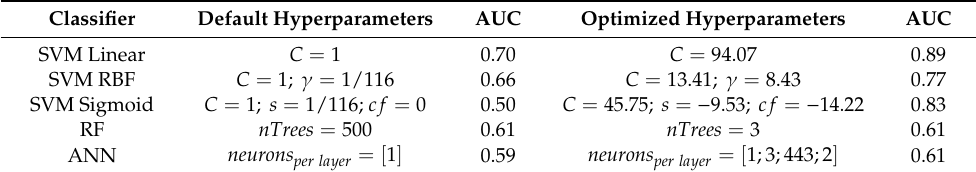
Table 3. Validation Classification Results.